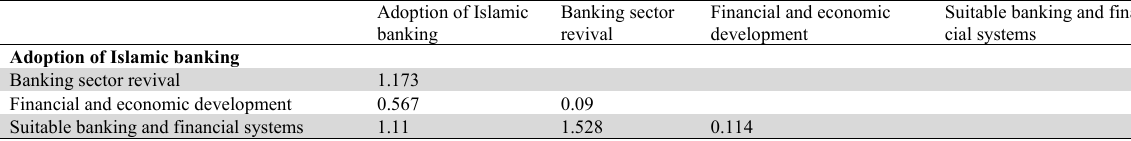
Heterotrait-Monotrait Ratio (HTMT) Analysis for Checking Discriminant Validity